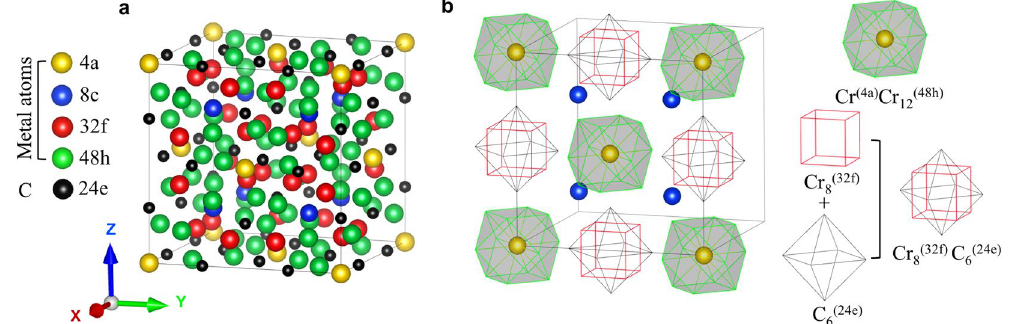
Figure 1. ( a ) The γ -Cr 23 C 6 supercell consists of one conventional unit cells with four inequivalent metal sites, namely, the 4a, 8c, 32f, and 48h sites, according to Wyckoff notation. The C atoms are located at the 24e sites. ( b ) The carbide NaCl super-ion morphology and interstitial (8c) atomic arrangement in γ -Cr 23 C 6 . The supercell is constructed from four Cr (4a) Cr 12(48h) clusters and four Cr 8(32f) C 6(24e) clusters, together with eight Cr atoms in the 8c